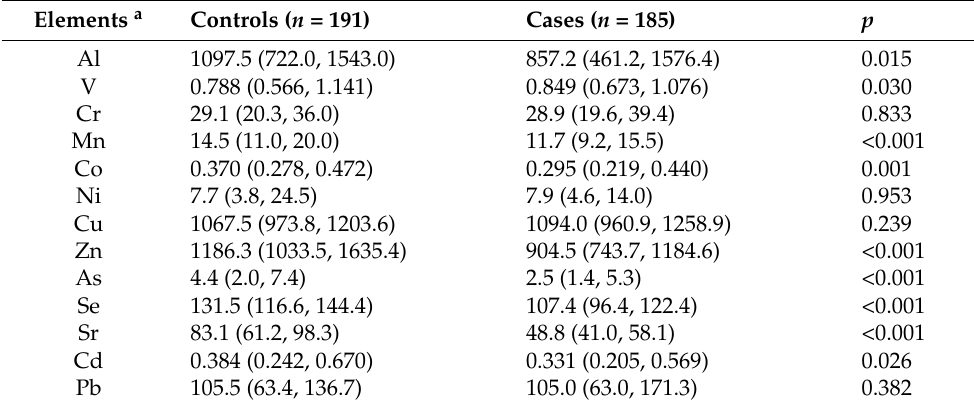
Table 2. Serum trace element concentrations ( µ g/L) in cases and controls.